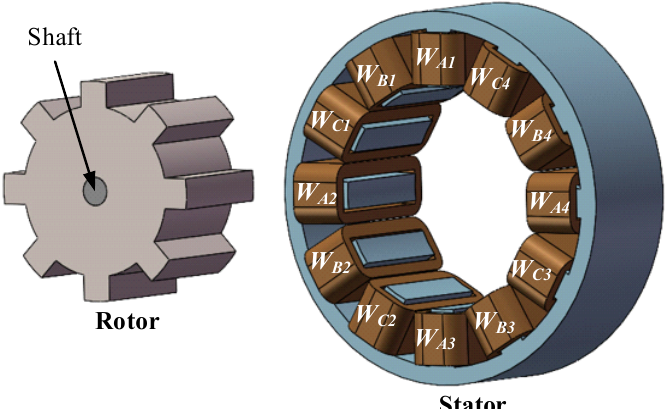
Figure 1. Diagram of traditional 12/8 SRM structure.